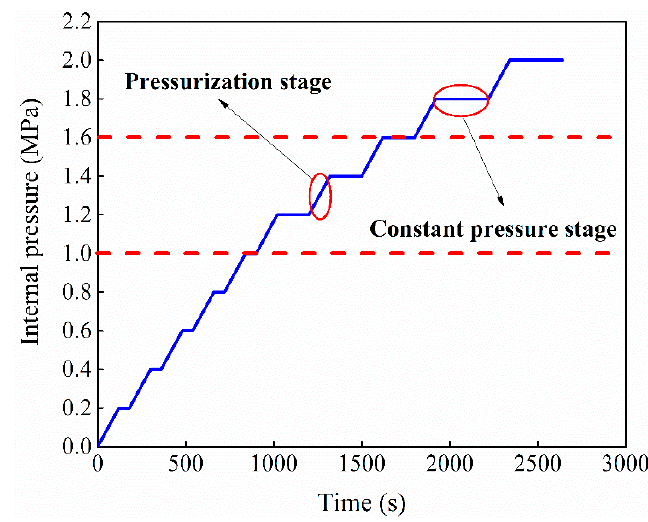
Figure 7. Pressurization